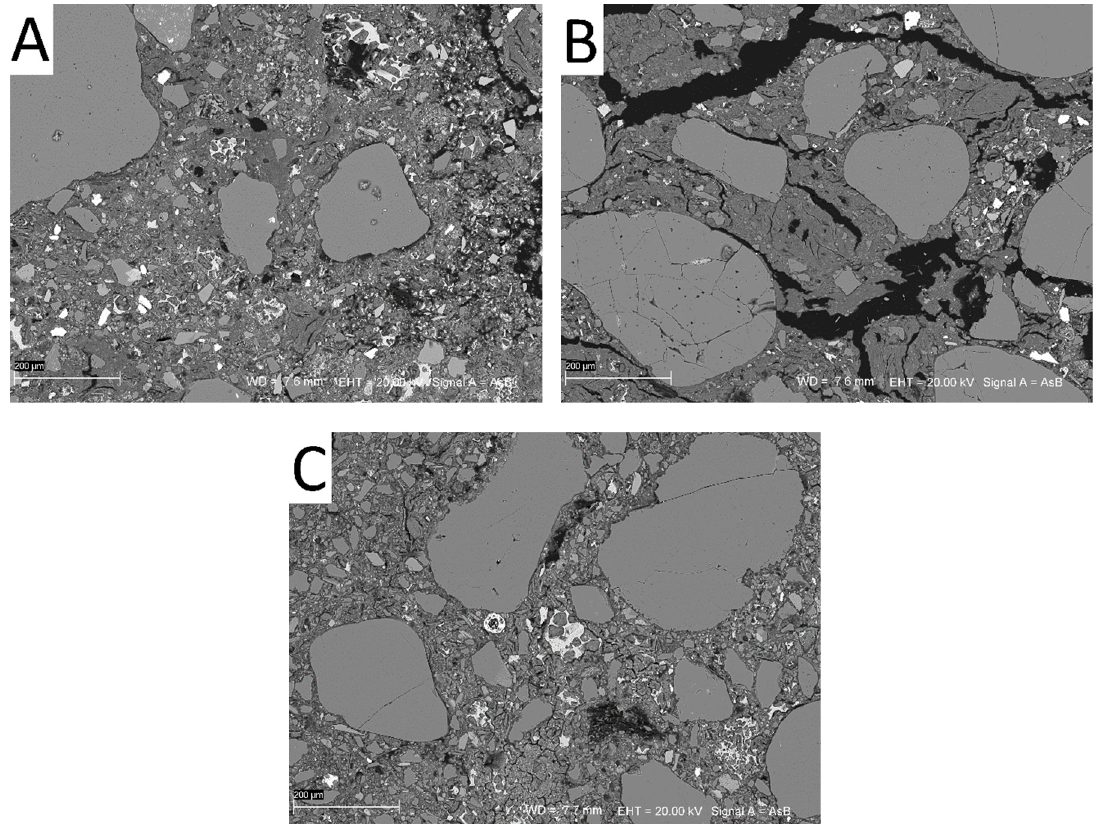
Figure 12. SEM images of samples MC V 9% CEM ( A ), MC X 9% CEM ( B ), and MC III 9% CEM ( C ). Symbols in the figures: WD—working distance; EHT—accelerating voltage; AsB—backscattered electrons (BSE) detector.